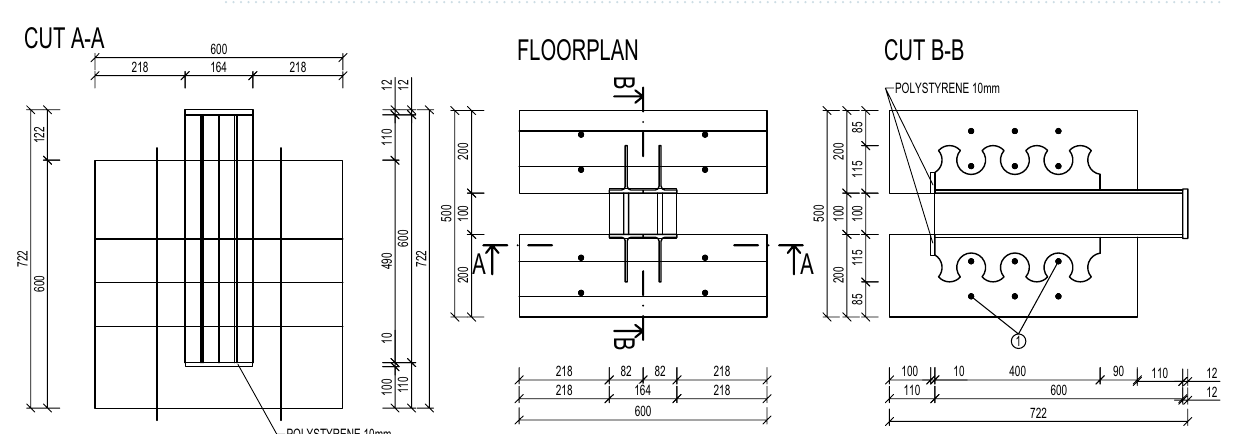
Figure 3. Layout of the twin dowel type shear connector for push-out